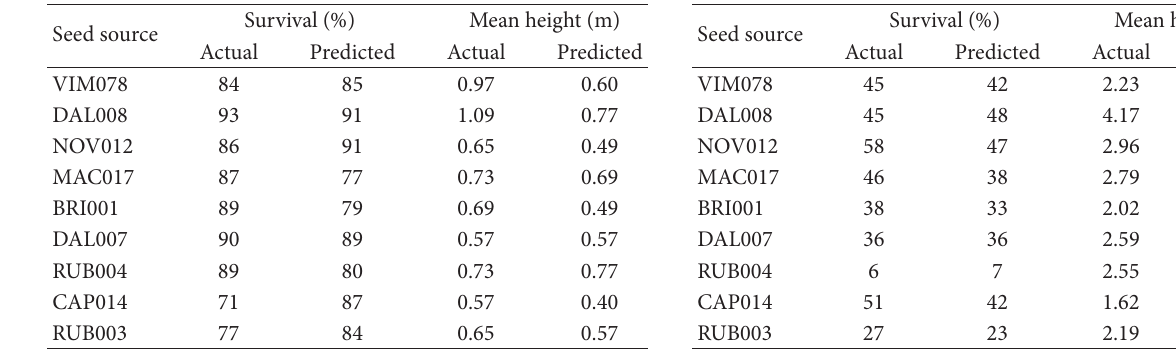
T 5: Comparison of actual versus predicted development—age 24